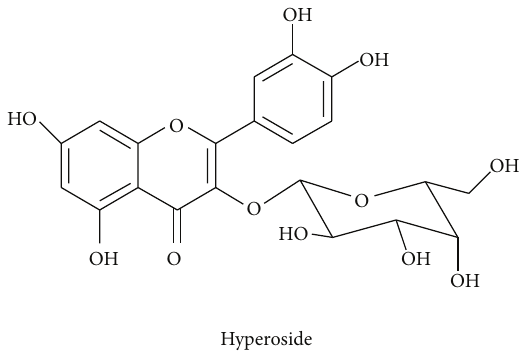
Figure 1: The structure of hyperoside